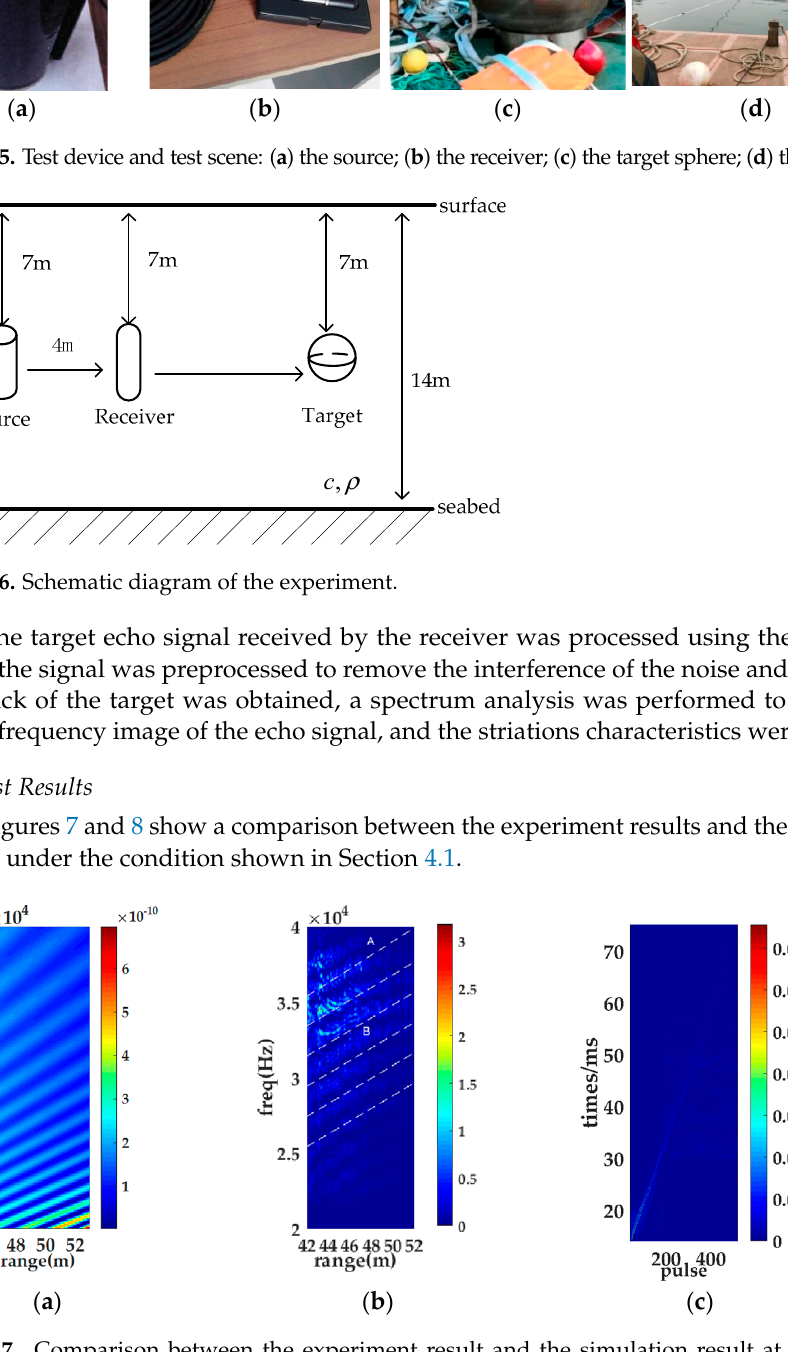
( c ) Figure 8. Comparison between the experiment result and the simulation result at 40 − 80 kHz: ( a ) simulation result; ( b ) experiment result; ( c ) the motion trajectory. Figures 7 and 8 show that the striations shape of the simulation results was con- sistent with that of the experimental results. Figures 7b and 8b show the intensity of the experimental striations varied with frequency. The target moved from near to far, and due to the attenuation characteristics of the signal in water, the intensity of the signal trace was weak at a longer range. The shape of the striations followed the shape of the target’s trajectory. The interference striations at the high frequency were denser than those at the low frequency. 5. The Striations Interference Phenomenon and Its Formation Mechanism From the above simulation and experimental results, four typical phenomena were observed, namely the bending, the density, the slope, and the discontinuities. These mechanisms were analyzed theoretically as follows. 5.1. The Phenomenon of Striations Bending and Its Generation Mechanism In the simulation results for the monostatic configuration (Figure 3), the striations were straight in all frequency bands. In Section 4, the striations obtained from the mono- static configuration experiments were also straight. However, in the bistatic configura- tion (Figure 4), the simulation striations became bent at every frequency band. In order to explain the phenomenon, we started with the definition of the waveguide invariant. From Equation (5), we obtained the relationship between ω and r, that is: